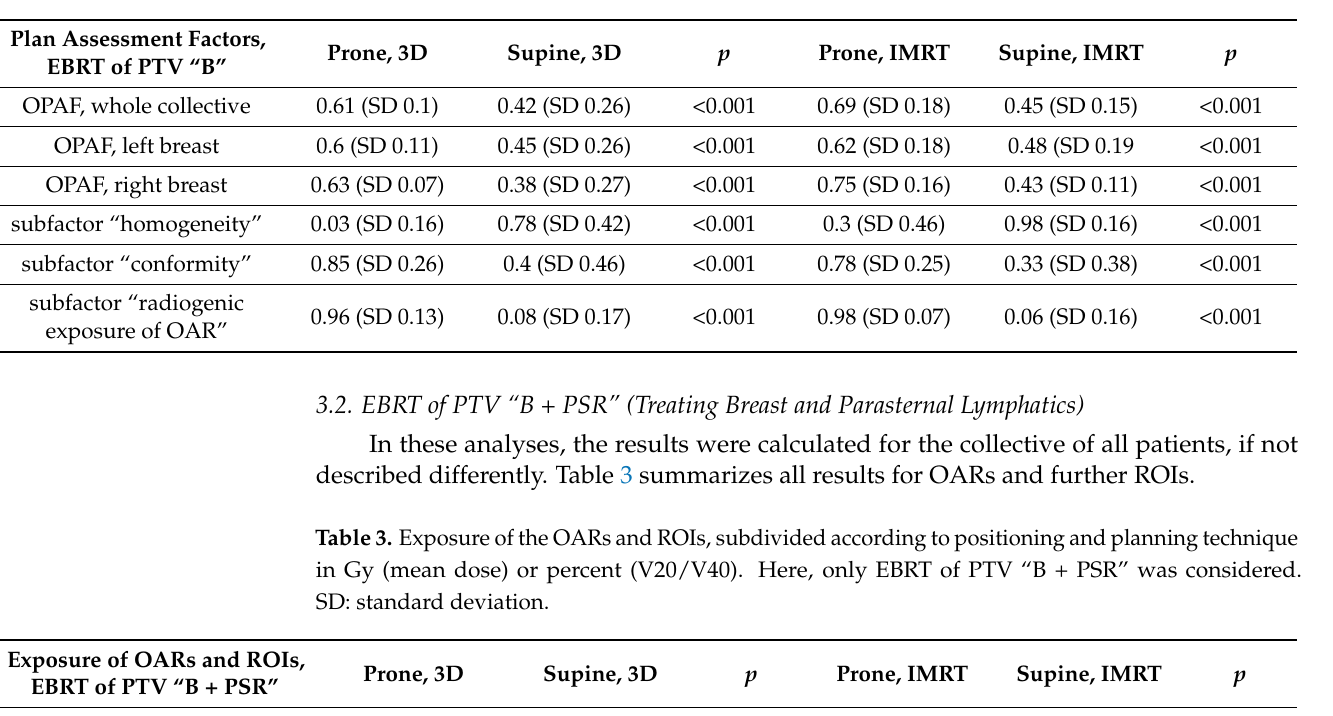
Table 2. Plan assessment factors for EBRT of PTV “B”. Listed are the overall plan assessment factors by the collective (left and right) as well as the individual subfactors, homogeneity, conformity, and radiogenic exposure of OAR, in each case for positioning in the prone and the supine positions as well as the 3D- and IMRT-planning technique. Each result reaches a value between 0 and 1 (whereby plan quality increases with the value). OPAF: overall plan assessment factor, OAR: organs at risk, SD: standard deviation.